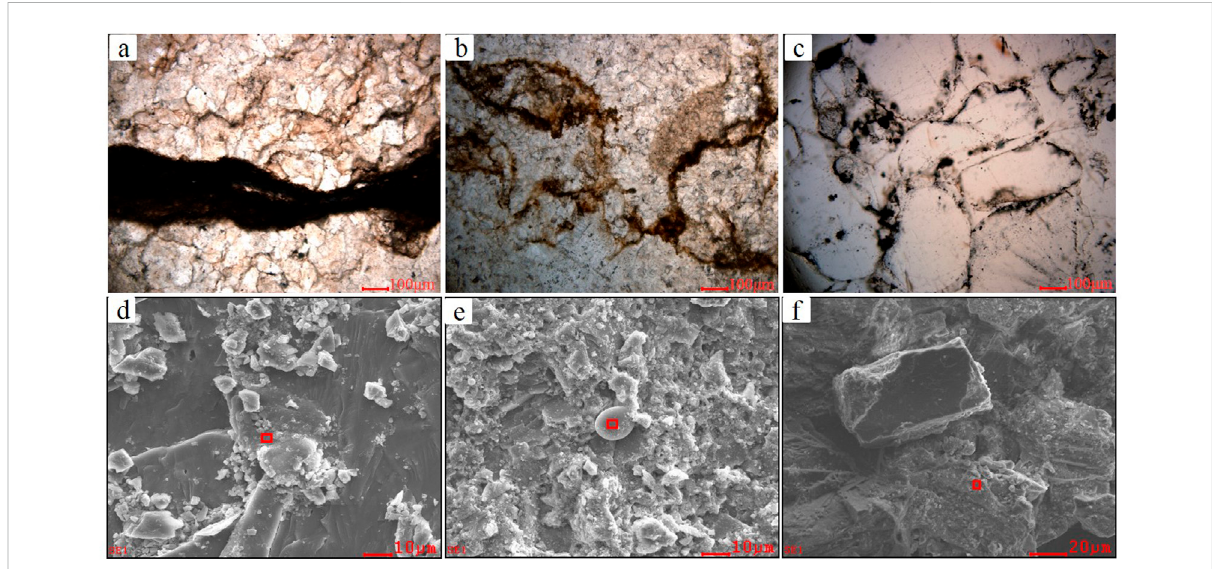
FIGURE 2 ExamplesofmicroscopicimagesshowingtheopticalcharacteristicsofsolidbitumenintheCambrianreservoirsoftheOrdosBasin. (A) Bitumen in fractured dolomite, ∈ 2 z, 4190.3 m, well L17; (B) bitumen in intergranular pores of limestone, ∈ 2 z, ZY outcrop in Shanxi province; (C) bitumen in the intercrystalline pores of sandstone, ∈ 2 x,4348.0 m, well T59; (D) bitumen in dolomite, ∈ 2 z, 4720.1m, well LT1; (E) bitumen in ooliticlimestone, ∈ 2 x,YJ outcrop in Shanxi province; (F) bitumen in dolomite, ∈ 1 s, 3982.0 m, well